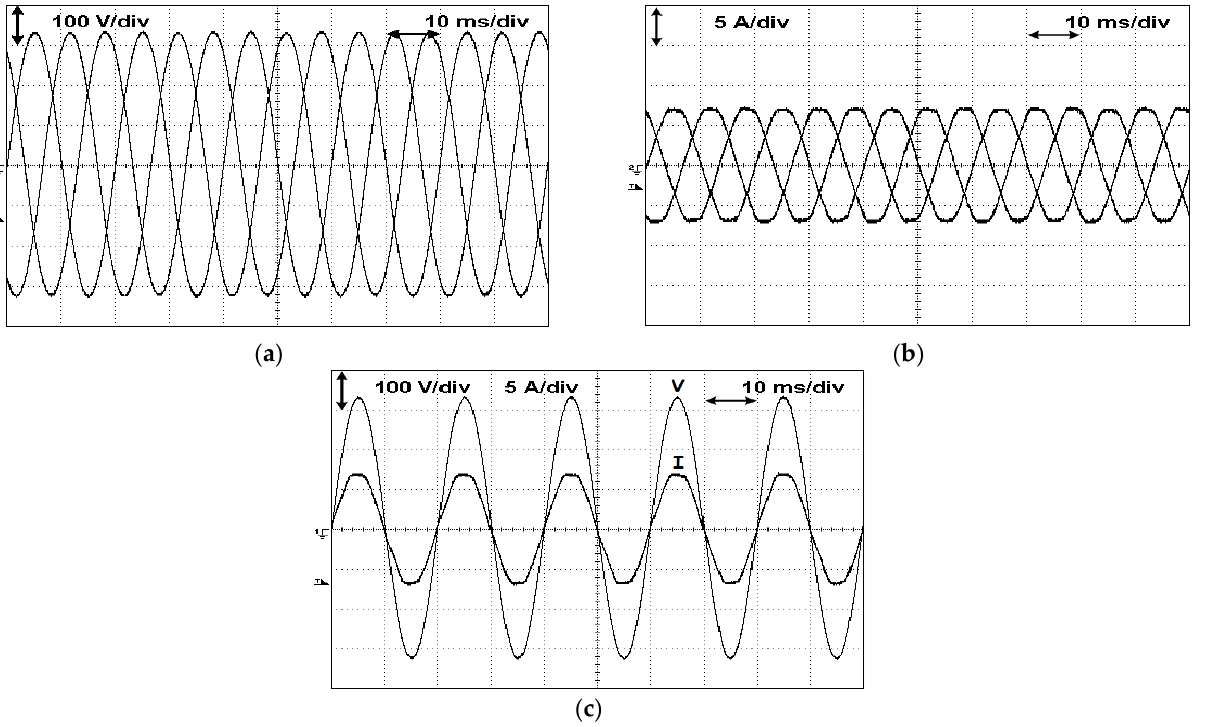
Figure 12. Waveforms obtained from the test using the PV inverter with four legs for a balanced condition and without reactive compensation: ( a ) three-phase voltages imposed by the testing system, ( b ) three-phase currents injected by the PV system, ( c ) voltage and current in phase L 1 of the testing system.